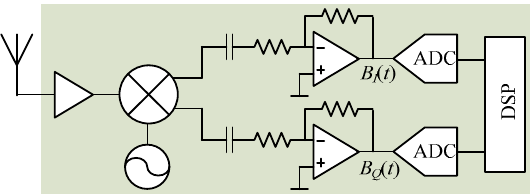
Figure 3. Quadrature Doppler radar receiver with I / Q channels.